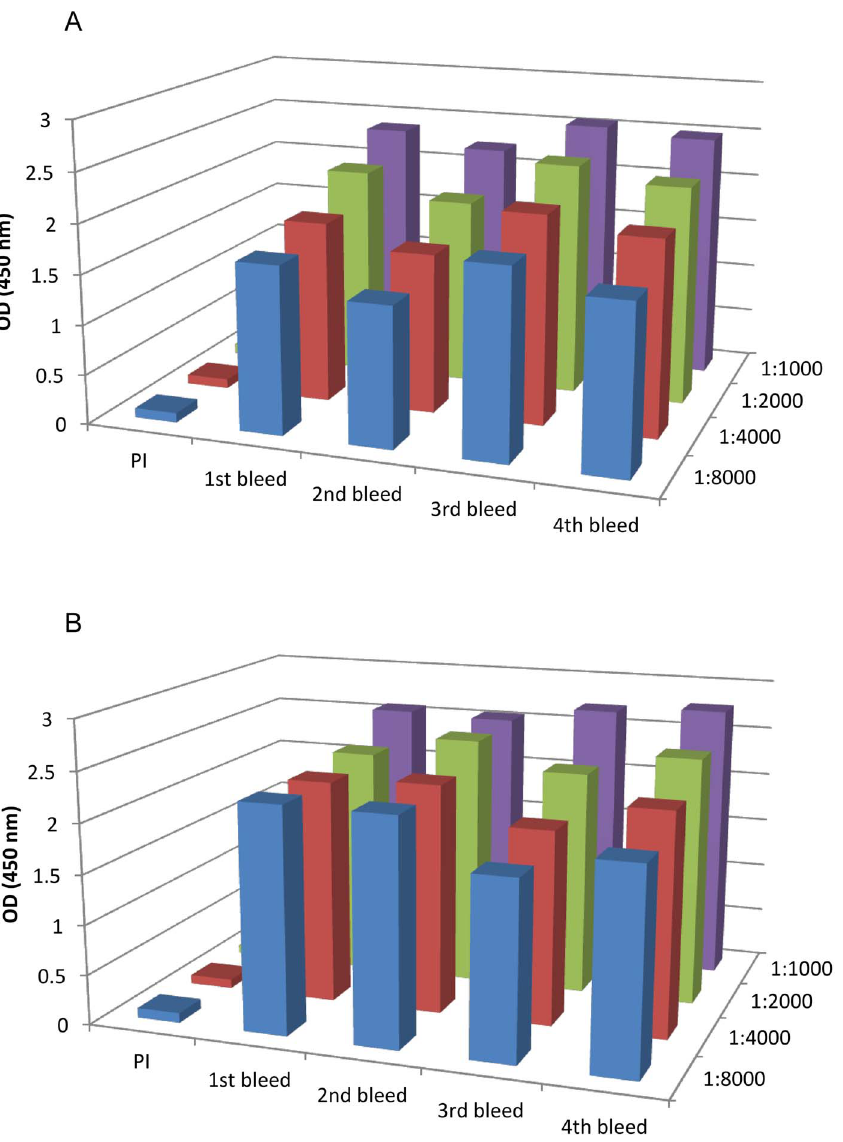
Figure 1. Activity of antiserum from pre-immune (PI) rabbits, 1 st bleeding (one week after 3 rd immunization), 2 nd bleeding (two weeks after 3rd immunization), 3 rd bleeding (one week after boost with additional immunogen), and 4 th bleeding (three weeks after boost). ELISA was performed using Sifin 2B as a capture antibody (1 m g/mL), Stx2 toxoid (10 ng/mL), and antisera of rabbits 5153 ( A ) and 5154 ( B ) diluted in a range of 1:1,000–1:8,000. Each column represents the mean of 3 independent repeats performed in duplicates, the standard deviation for each column ranges from 0.01 to 0.15.